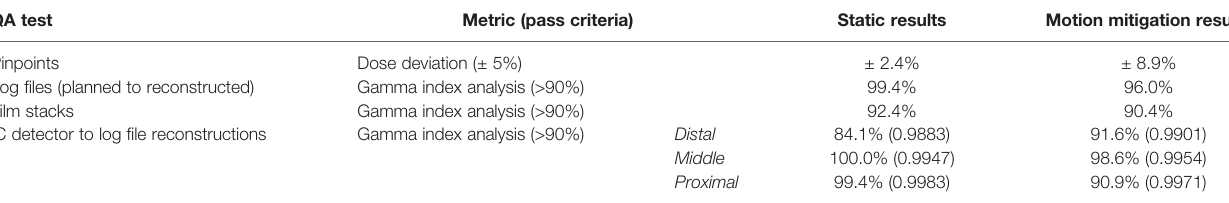
TABLE 5 | Summary of patient speci fi c quality assurance results for four measurements. QA test Metric (pass